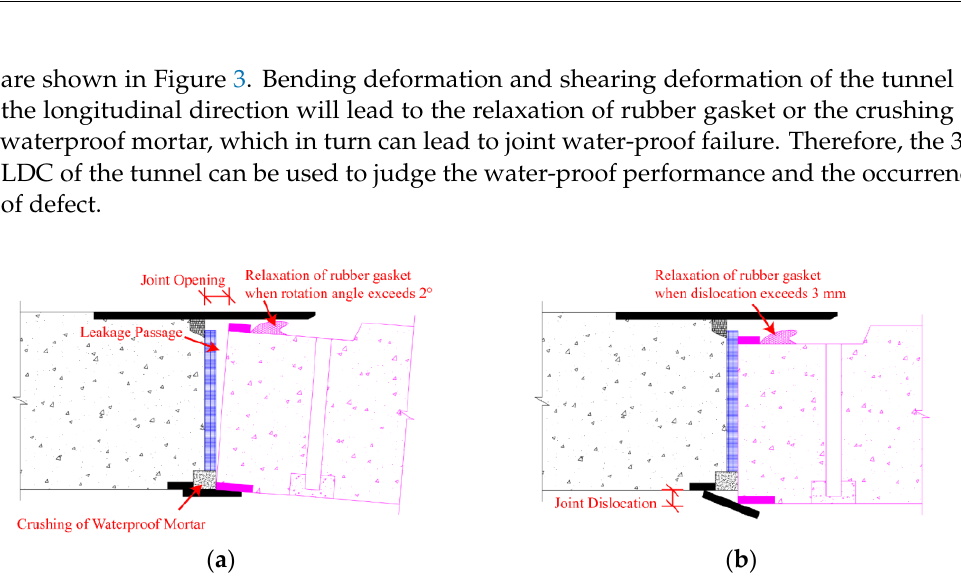
Figure 3. Schematic diagram of F-shaped joint water-proof failure due to longitudinal deformation: ( a ) Joint water-proof failure due to bending deformation; ( b ) Joint water-proof failure due to shearing deformation.